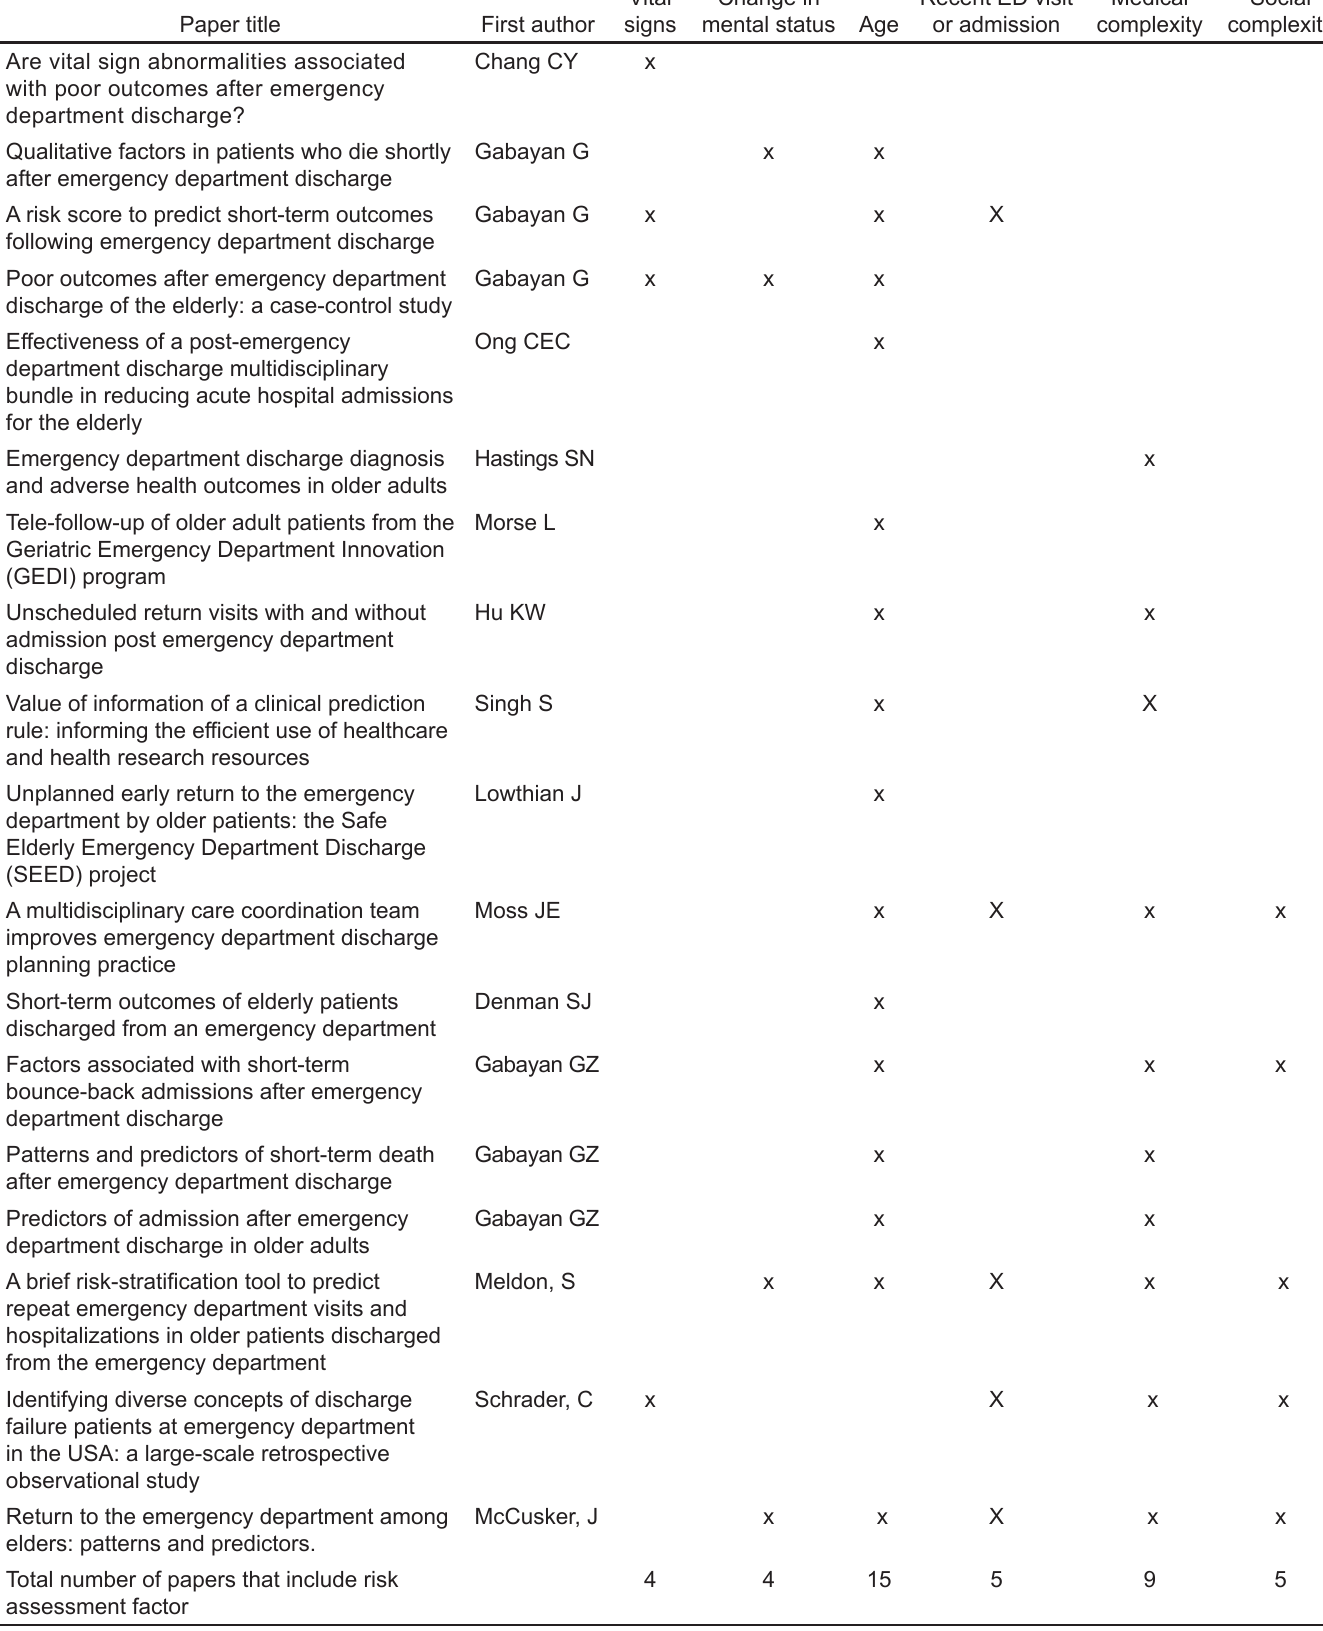
Table 2. Factors commonly included in discharge risk